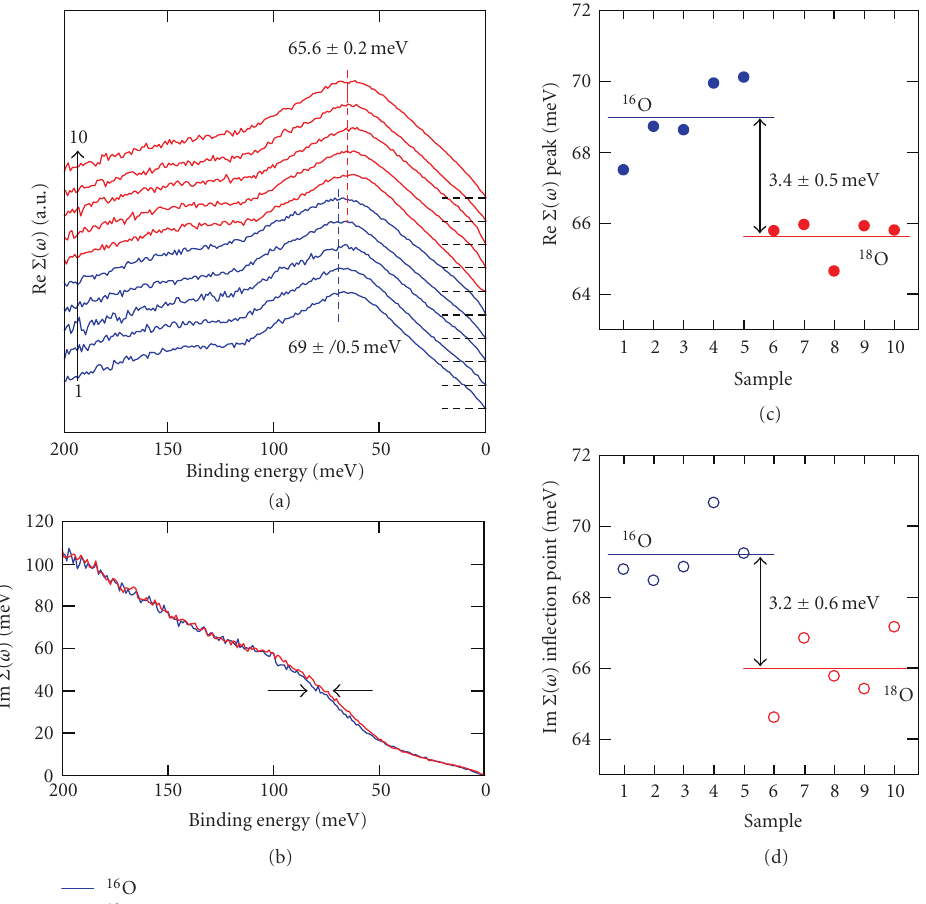
Figure 6: (a) Real part of the self-energy Re Σ ( ω ) from five samples both for 16 O (lower curves) and 18 O (upper curves). All Re Σ ( ω ) are deduced by subtracting a bare band dispersion from the experimental one. (b) Imaginary part of the self-energy Im Σ ( ω ) determined from the full width of the momentum distribution curves. (c), (d) Obtained kink energy as a function of sample numbers both for 16 O (to the left) and 18 O (to the right) from Re Σ ( ω ) and Im Σ ( ω ), after Iwasawa et al. [113].